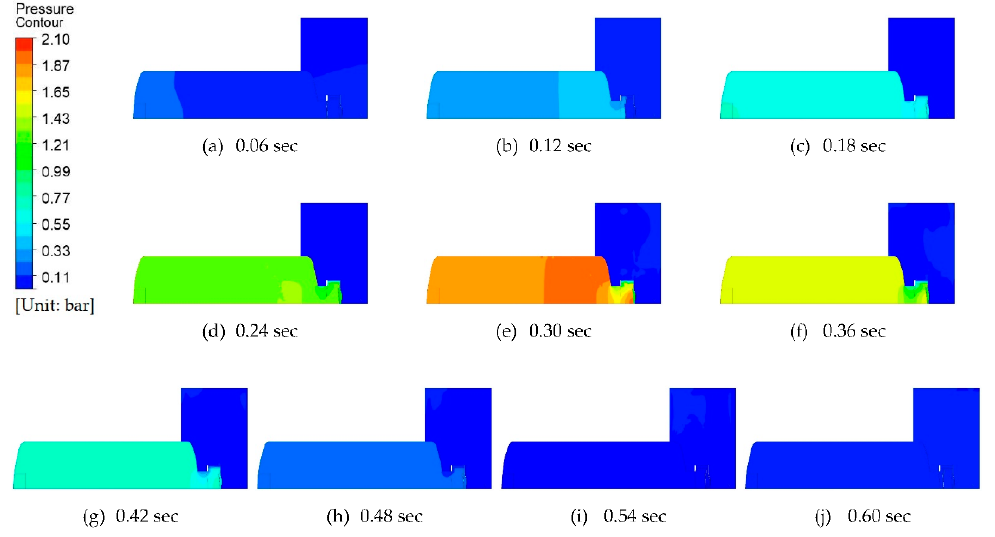
Figure 4. Pressure contour results after the explosion.